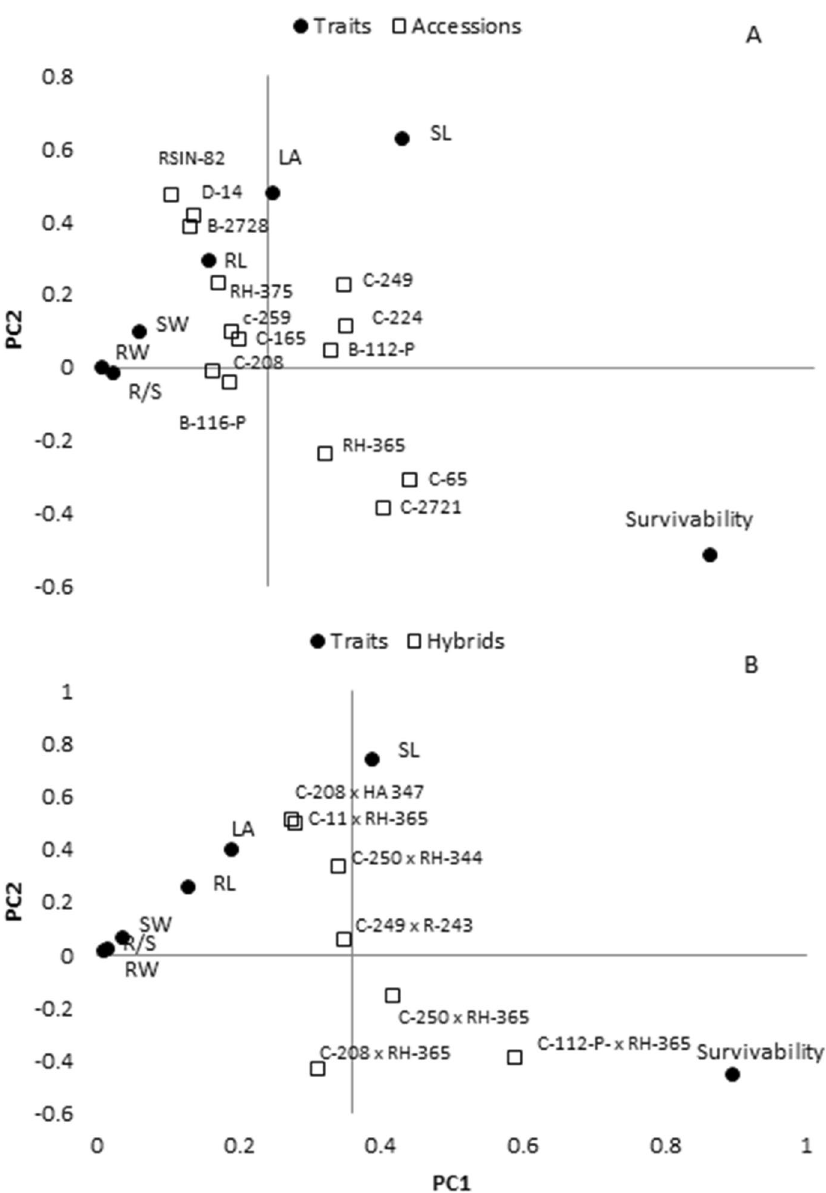
Figure 3. .Genotype + Genotype × parameters,i.e. shoot weight (SW g), shoot length (SL cm), root weight (RW g), root length (RL cm) leaf area (LA cm 2 ), root to shoot ratio (R/S) biplot analyses ( A ) sunflower accessions by parameters, ( B ) hybrids by parameters, PC1 = principle component 1 and PC2 = Principle component